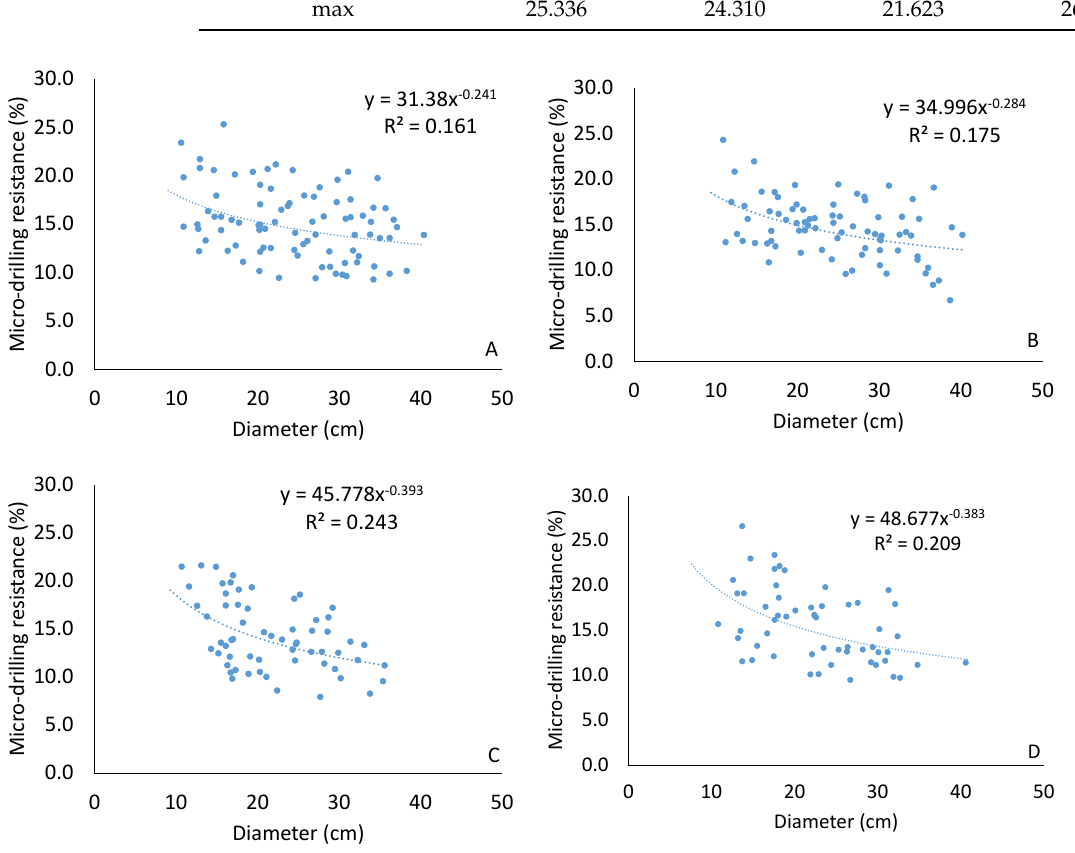
Figure 5. Relationship between trunk diameter and wood resistance to microdrilling, differentiated on plantation variant ( A ) V1, 2500; ( B ) V2, 3330; ( C ) V3, 5000; ( D ) V4, 7510 trees · ha − 1 . The relationship between resistance in the microdrill resistance test and trunk diameter